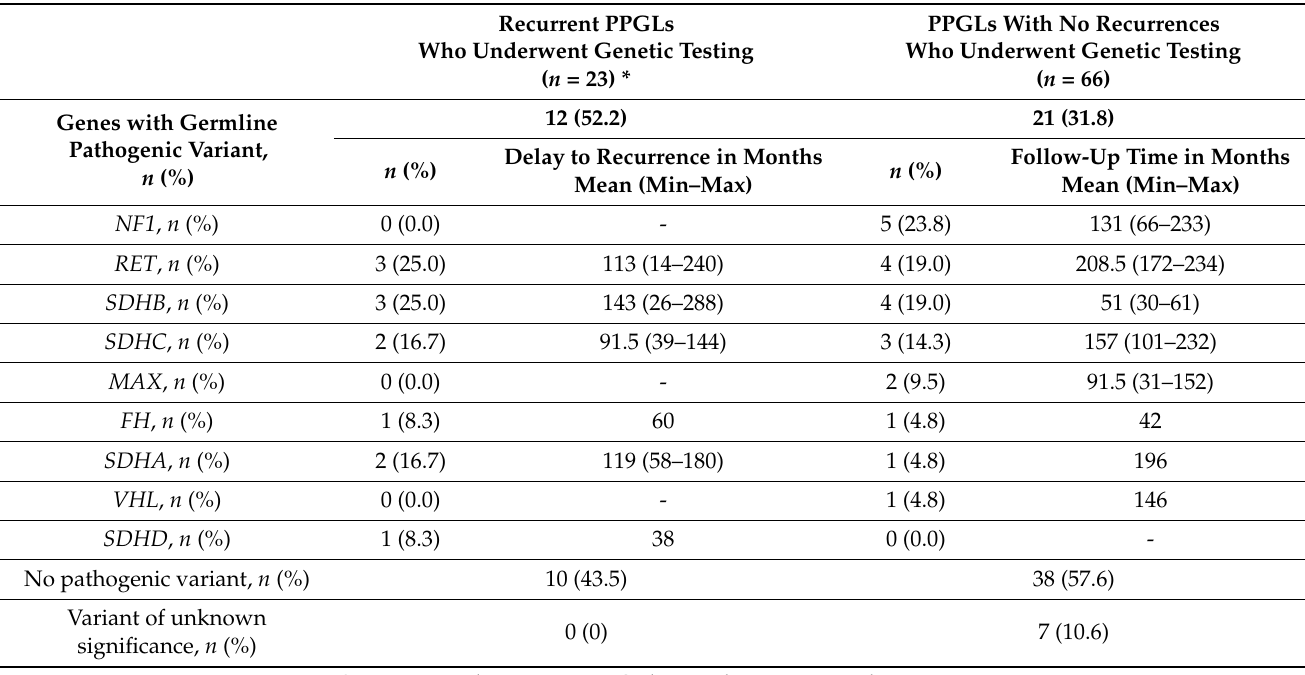
Table 1. Genetic description of patients with and without recurrent PPGLs.